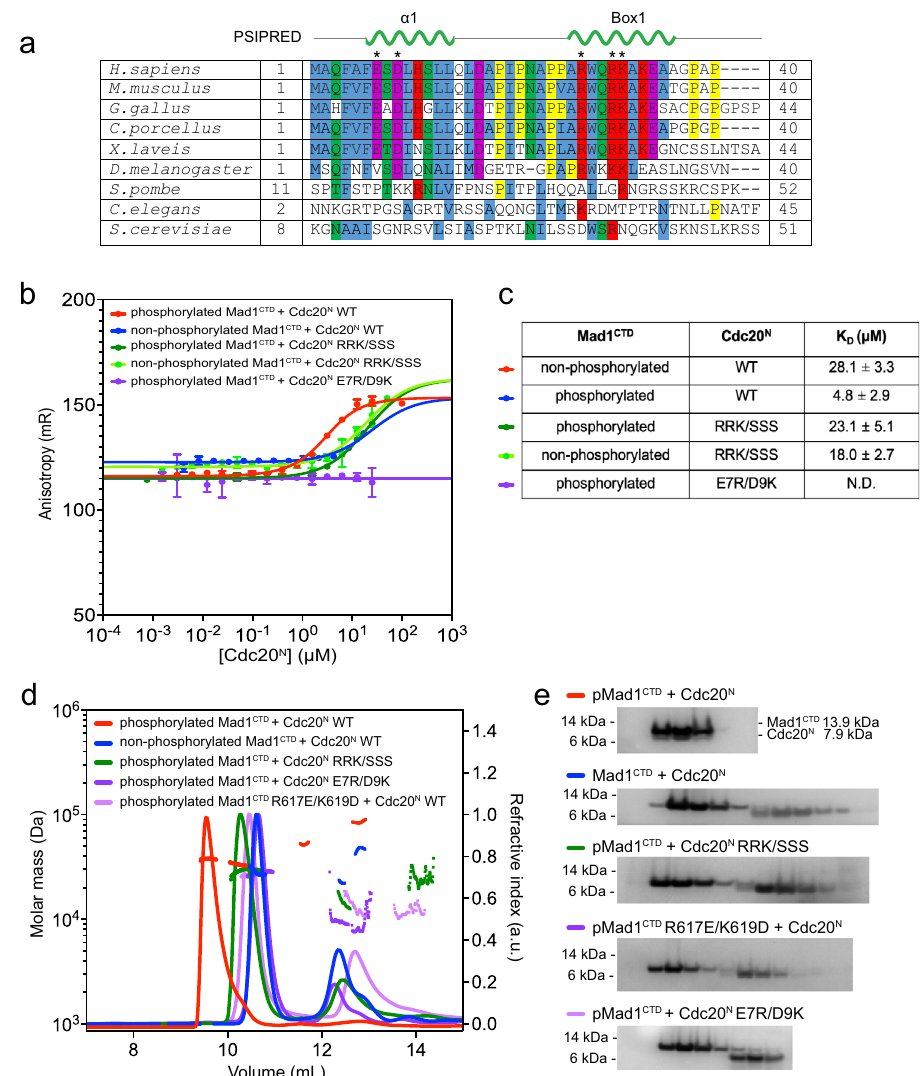
Fig. 5 | Binding of Cdc20 N and Mad1 CTD mutants by fl uorescent anisotropy and SEC-MALS. a A multiple sequence alignment of Cdc20 1 – 40 . Secondary structure prediction by PSIPRED is shown above for the α 1 and Box1 predicted helices. The asterisksdenoteresidueswhichweremutatedandtestedby fl uorescentanisotropy or SEC-MALS in b – d . b Fluorescent anisotropy with preformed AF488- Bub1 CD1 :Mad1 CTD complex (20nM: 2.1 µ M) using pMad1 CTD or Mad1 CTD and where various Cdc20 N mutants were titrated. The data were presented as mean values± SDderivedfromthreeindependentmeasurements. c Summaryofthecalculated K D